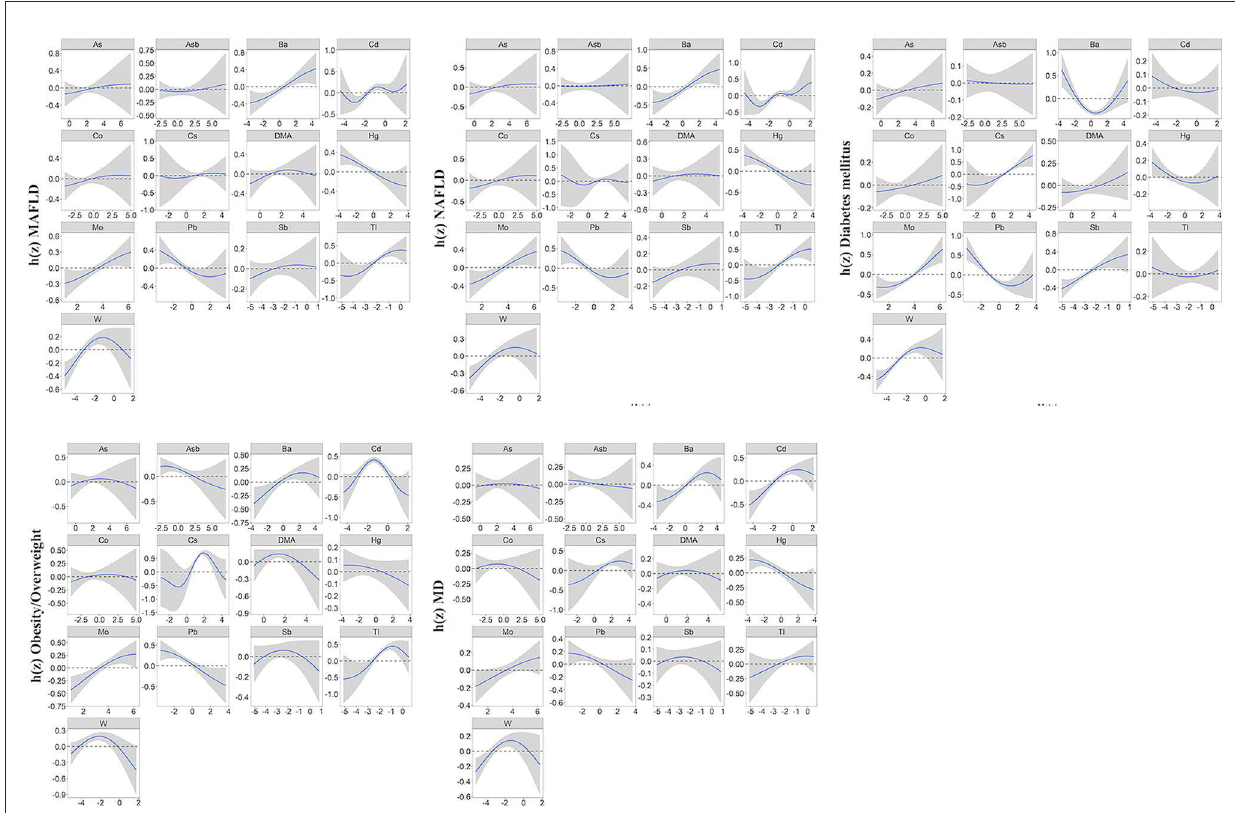
FIGURE3 Univariate exposure-response function (95%CI) showed associations of heavy metals with MAFLD, NAFLD, and MAFLD components. All the remaining metal exposures are fixed at their median values. Results were adjusted for age, gender, race, research cycle, education level, smoking status, PIR, and physical activity. BKMR, Bayesian kernel machine regression; MAFLD, metabolic associated fatty liver disease; NAFLD, non-alcoholic fatty liver disease; MD, metabolic dysfunction; PIR, poverty income